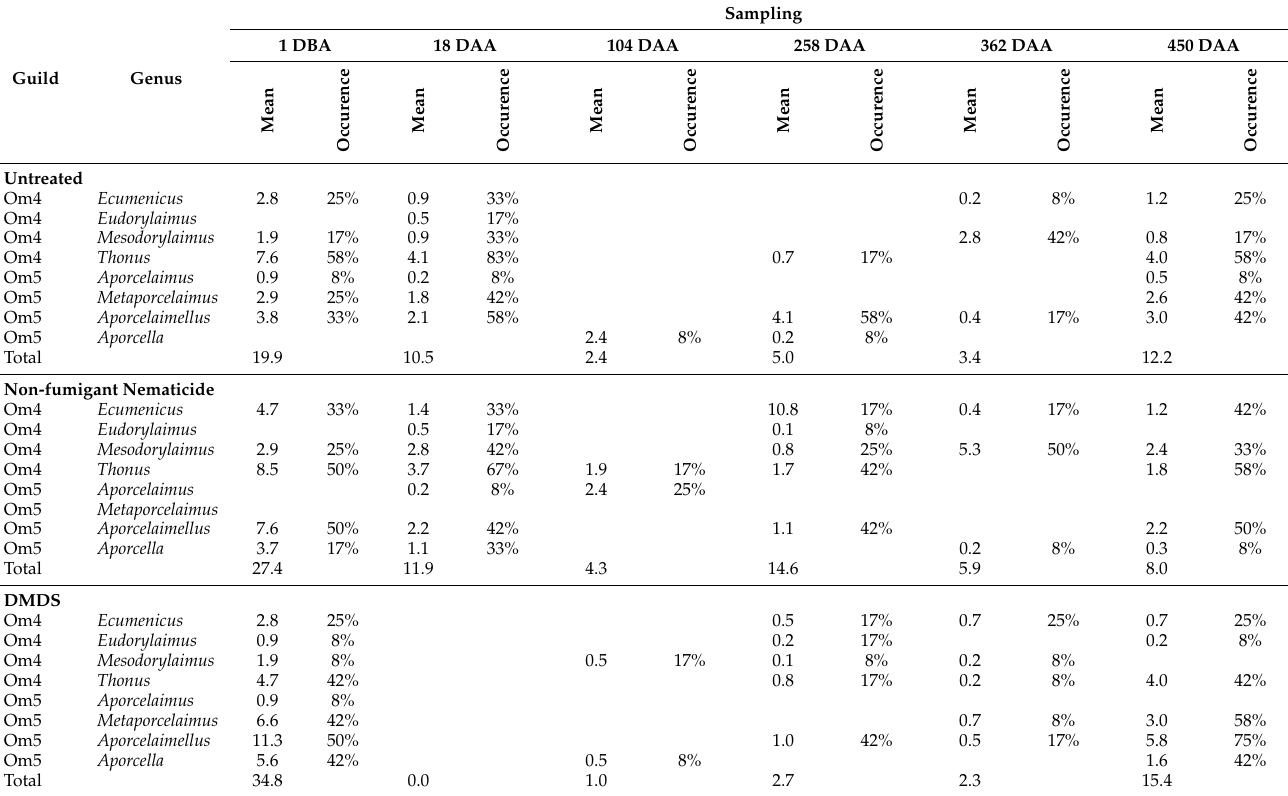
Table A4. Omnivorous nematodes—structure. Abundance and occurrence in trial variants during the study